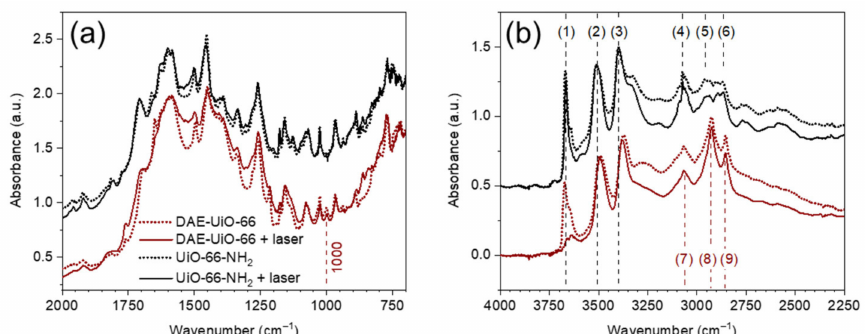
Figure 5. FTIR spectra of UiO-66-NH 2 (black ones) and DAE-UiO-66 (brown ones) samples in the 700–2000 cm − 1 ( a ) and 2250–4000 cm − 1 ( b ) region. In both parts, spectra of the samples before laser irradiation are represented by dotted lines, while solid lines show spectra of the samples after 10 min of irradiation (wavelength 520 nm).